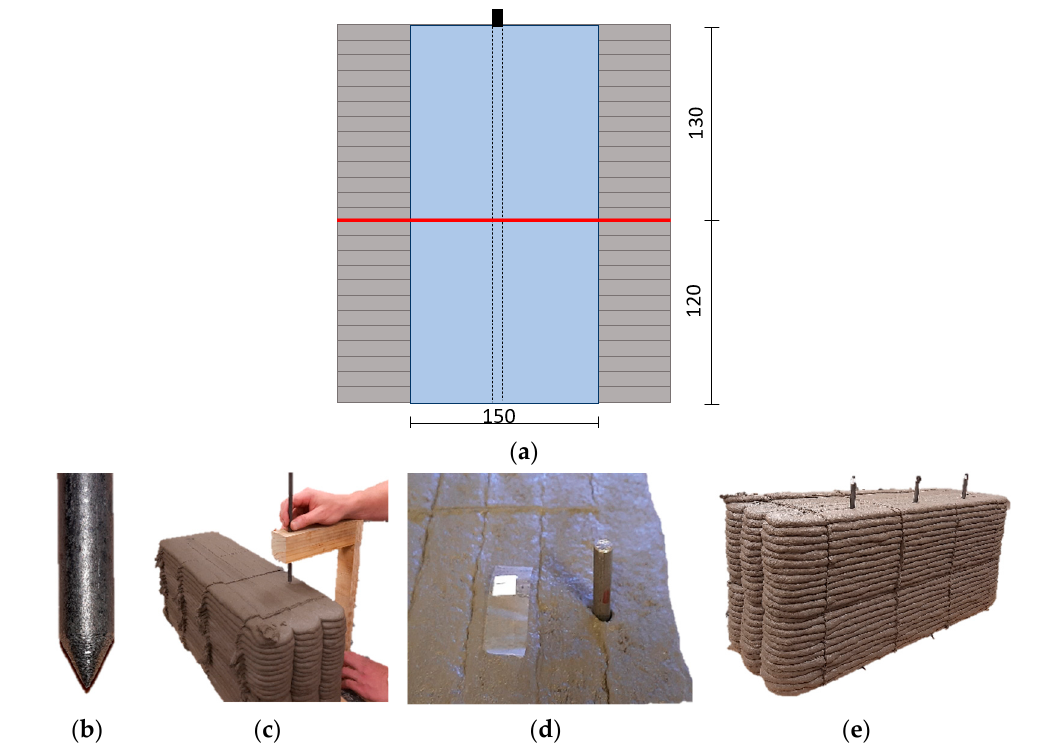
Figure 7. ( a ) Extraction of a printed CIC beam schematized, (red line indicating the CL), and subsequent placement of ( b ) a sharpened steel bar ( c ) with the aid of a jig, showing ( d ) final placement of a bar, and ( e ) several reinforced specimens.